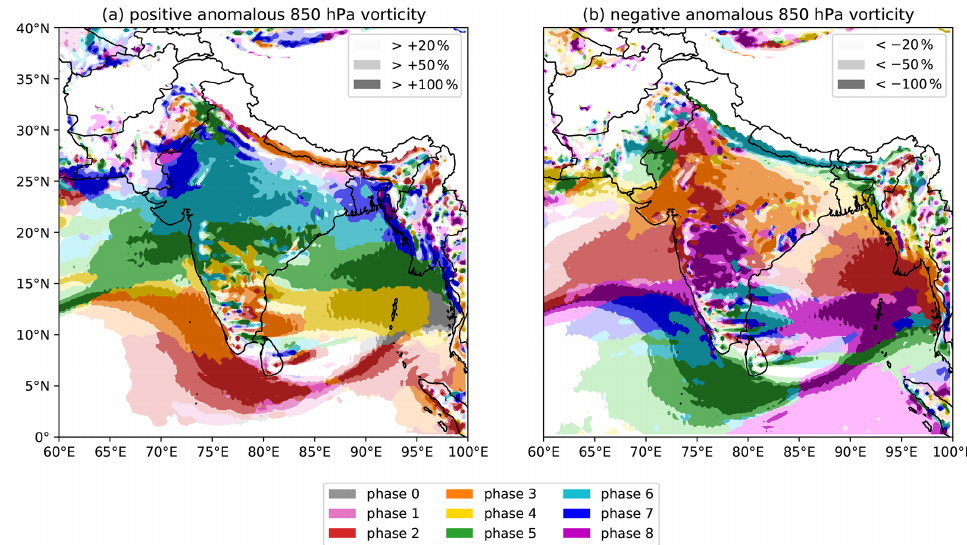
Figure 3. The effect of the BSISO on 850hPa relative vorticity during the summer monsoon over South Asia. Colours indicate the BSISO phase for which mean relative vorticity is (a) the highest and (b) the lowest. Three levels of lightness for each colour denote the difference between the mean relative vorticity in that phase and the full climatology, stratified at ± 20%, ± 50% and ± 100%. Areas where surface elevation is higher than 1500m are masked. A colourblind-friendly version of this figure, with the anomalies plotted separately for each BSISO phase, is given in Fig. S3.